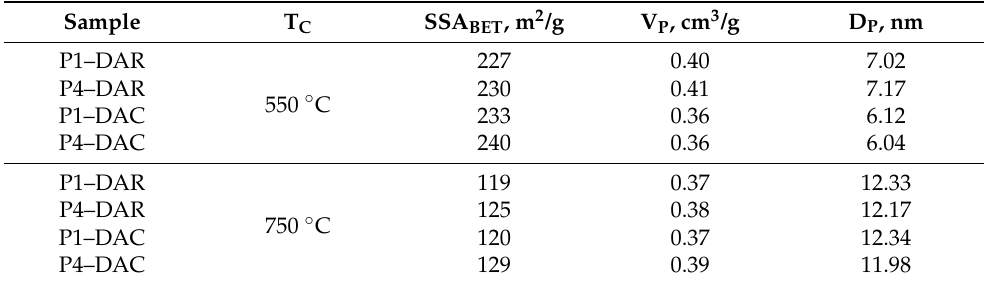
Table 4. Textural properties of the 25SA microspheres calcined at 550 ◦ C and 750 ◦